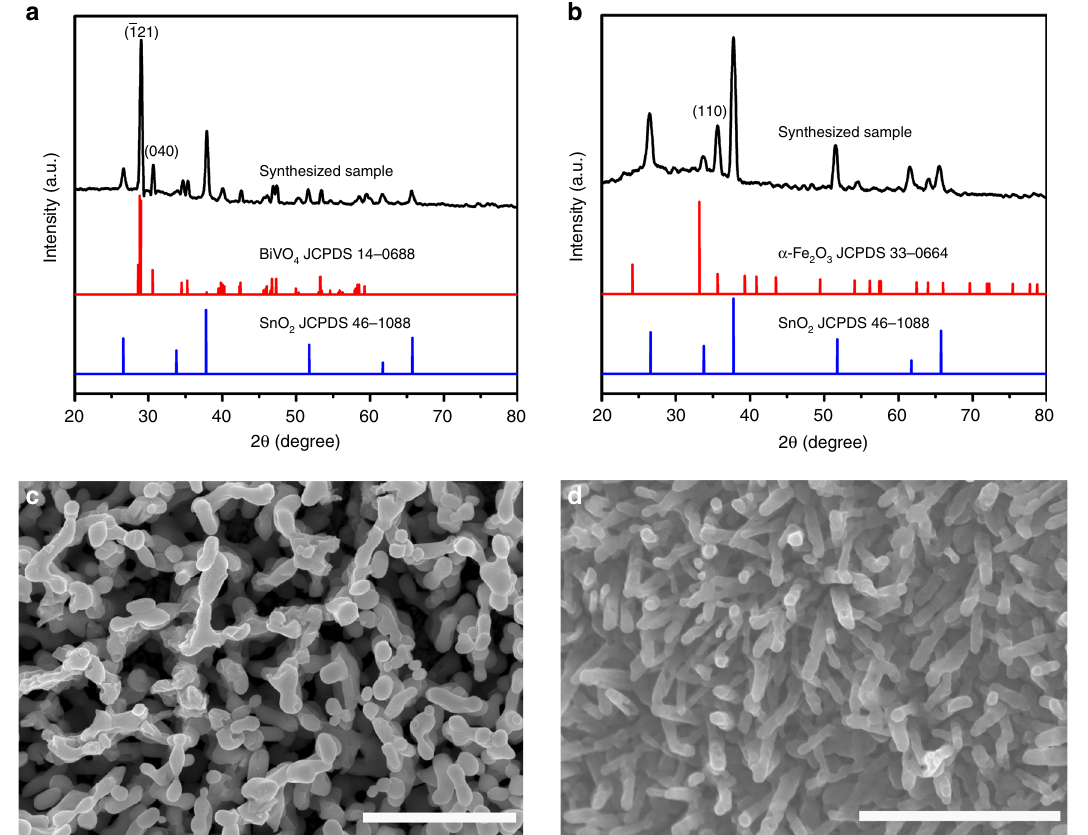
Fig. 2 Characterization of the photoelectrodes. XRD patterns of a BiVO 4 fi lm and b α -Fe 2 O 3 fi lm. SEM images of c BiVO 4 and d α -Fe 2 O 3 . Scale bars in c , d are 1 μ